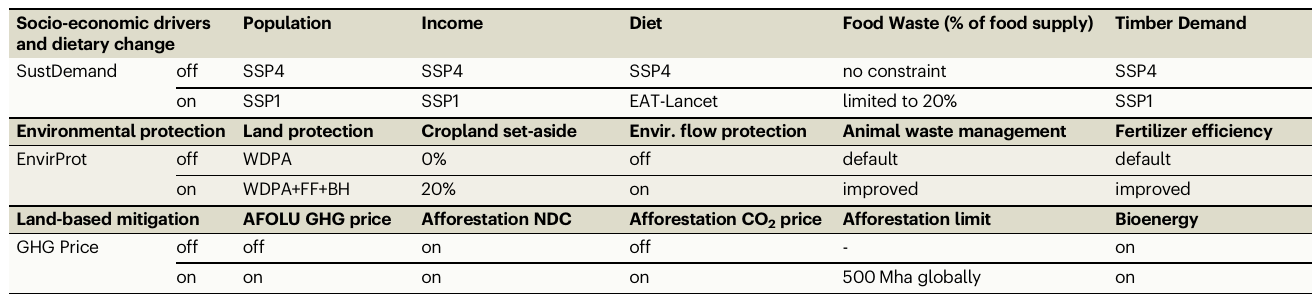
Table 3 | Grouping of scenario